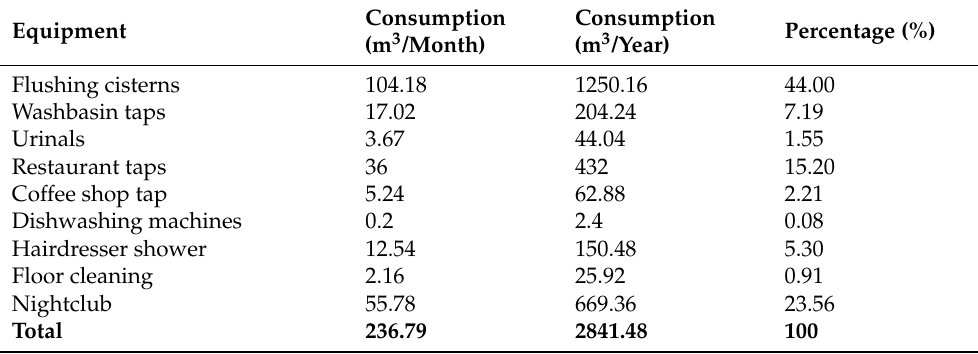
Table 3. Monthly and annual water consumption in the Market building by use category.